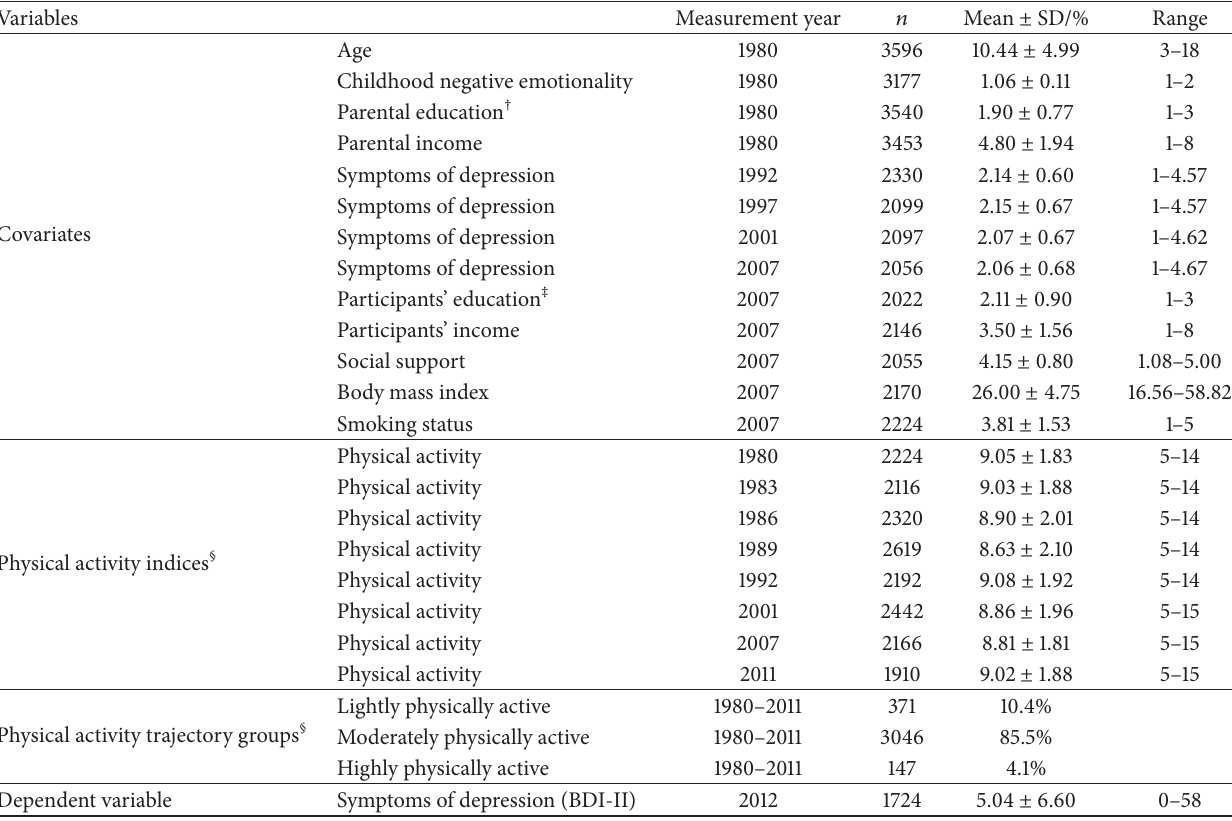
Table 1: Descriptive statistics of the original sample ( 𝑛 = 1724 –3596) ∗